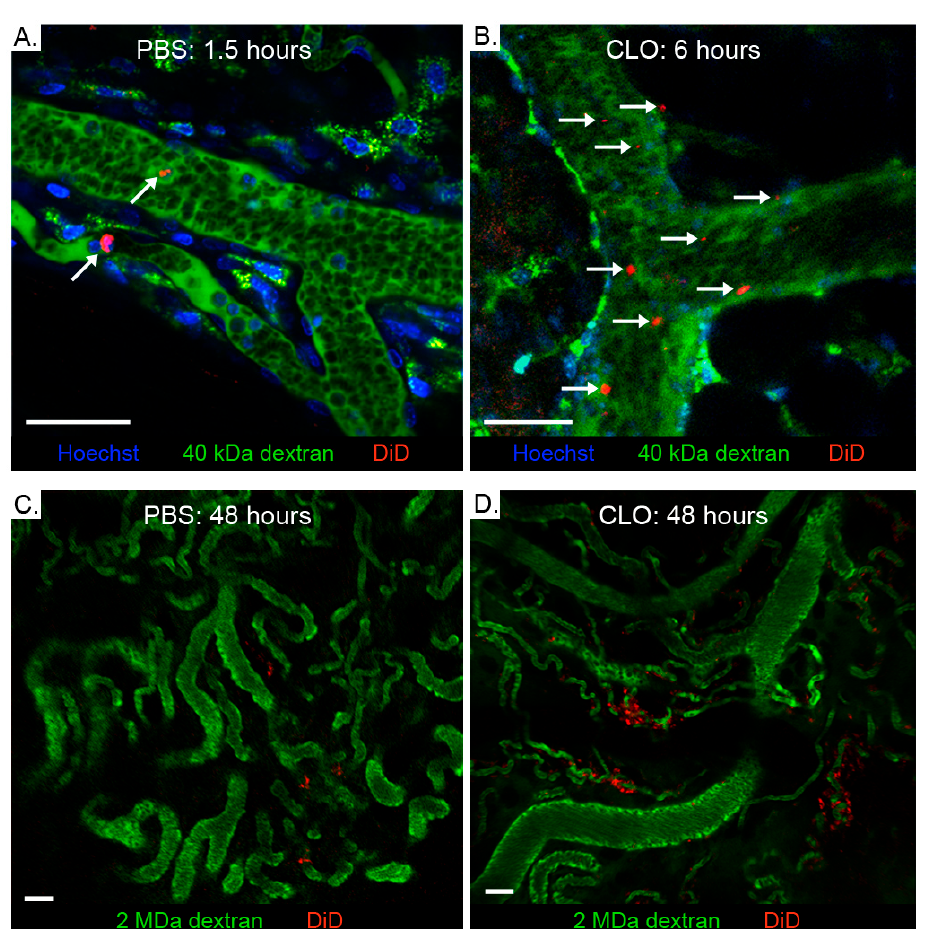
Figure 2. Depletion of the mononuclear phagocyte system prolongs the circulation of exogenously administered BMDMs. Mice were first pretreated with either PBS or CLO liposomes. After 24 h, 10 6 DiD-labeled BMDMs were injected and their appearance in the tumor microenvironment was monitored by intravital microscopy. In PBS-pretreated mice ( A ), only a few circulating DiD-labeled BMDMs (red, arrows) can be seen 90 min after their administration, whereas 6 hours after their administration many BMDMs were still detected in the blood of CLO liposomes-pretreated mice ( B ) (see also accompanied Supplementary video S1). Hoechst (blue) and 40 kDa TMR-dextran (green) were systemically injected before imaging to discriminate endogenous macrophages (green) from exogenous BMDMs (red). Residual 40 kDa TMR-dextran in the blood within the first hours after injection